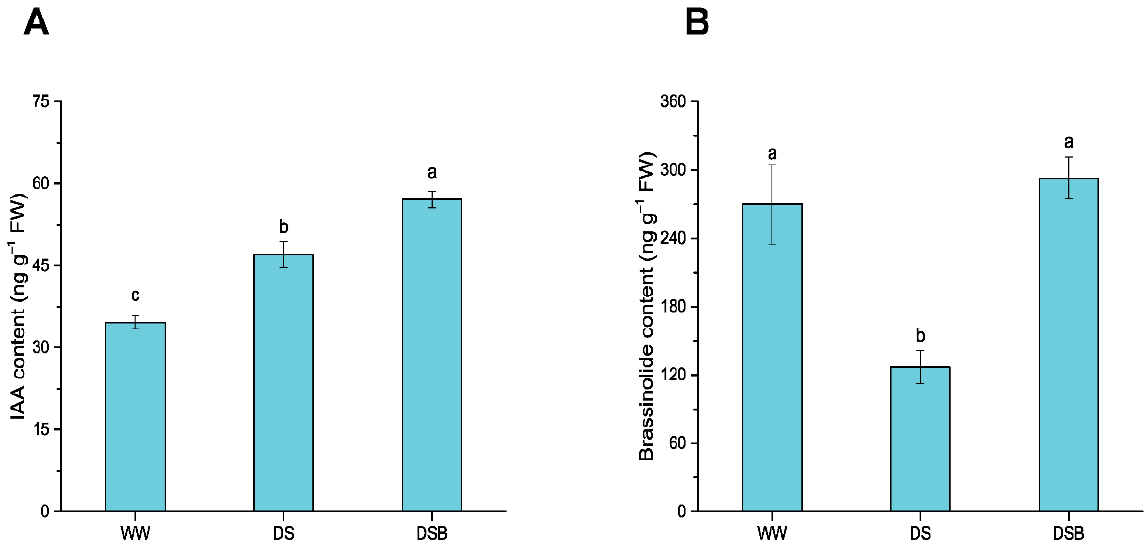
Figure 7. 2,4-epibrassinolide (EBR) application improved phytohormone content, such as auxin (IAA) ( A ) and brassinolide content, in response to drought stress ( B ). The data are presented as means ± SE in the three treatments including WW (well-watered), DS (drought stress), and DSB (drought stress + 0.05 mM EBR application). Error bars represent SE of the mean; different letters on bars show significant differences at p < 0.05 using the LSD test.